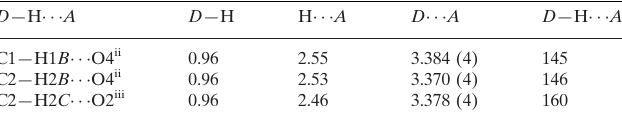
Hydrogen-bond geometry (A˚ , (cid:3)